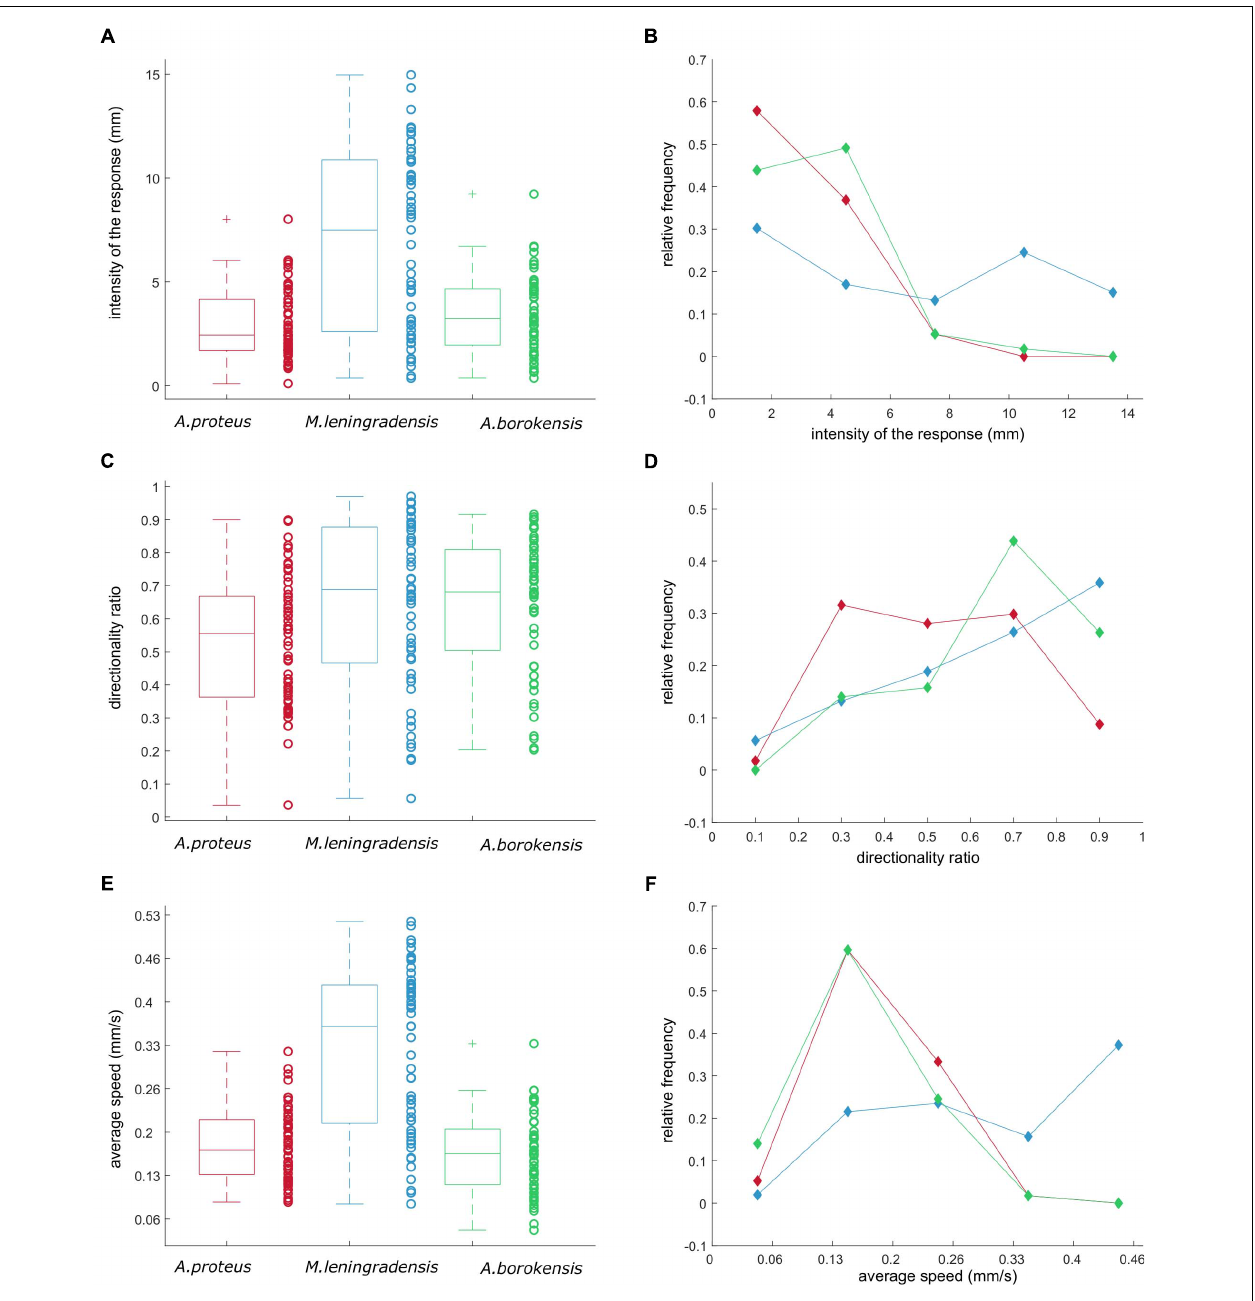
FIGURE 5 | The intensity of response, directionality ratio, and average speed of the cells that acquired conditioned behavior. (A , C , E) panels illustrate boxplots for the intensity of response (measured in mm), the directionality ratio, and the average speed (measured in mm/s), respectively (where A. proteus is represented in red, M. leningradensis in blue, and A. borokensis in green). On the side of each box, the values of the statistic for each cell were depicted by circles. Panels ( B , D , F) illustrate the frequency polygons corresponding to the statistics in panels (A , C,E) , respectively. Here, the x -axis indicates the value of the statistic, while the y -axis represents the relative frequency (i.e., the number of cases divided by the total number of cells of that species) for the three cell types.